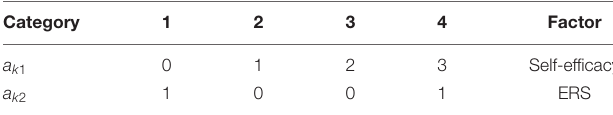
TABLE 7 | Scoring functions for mathematics self-efficacy and